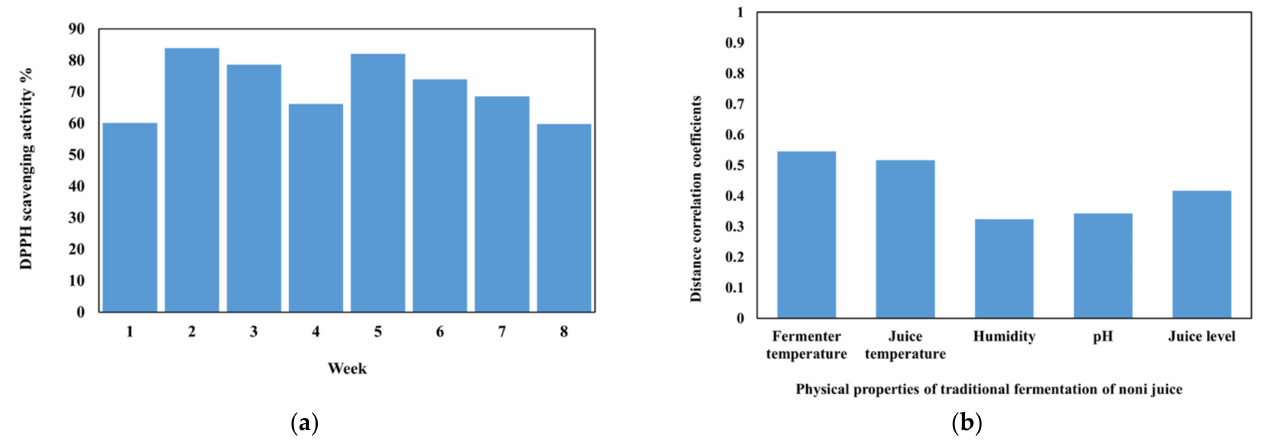
Figure 3. The associations of the physical properties with the antioxidant capacity of fermented noni juice. ( a ) Variation in the antioxidant capacity of noni juice during traditional fermentation. ( b ) The distance correlation coefficients of the physical properties of the traditional fermentation of noni juice with its antioxidant